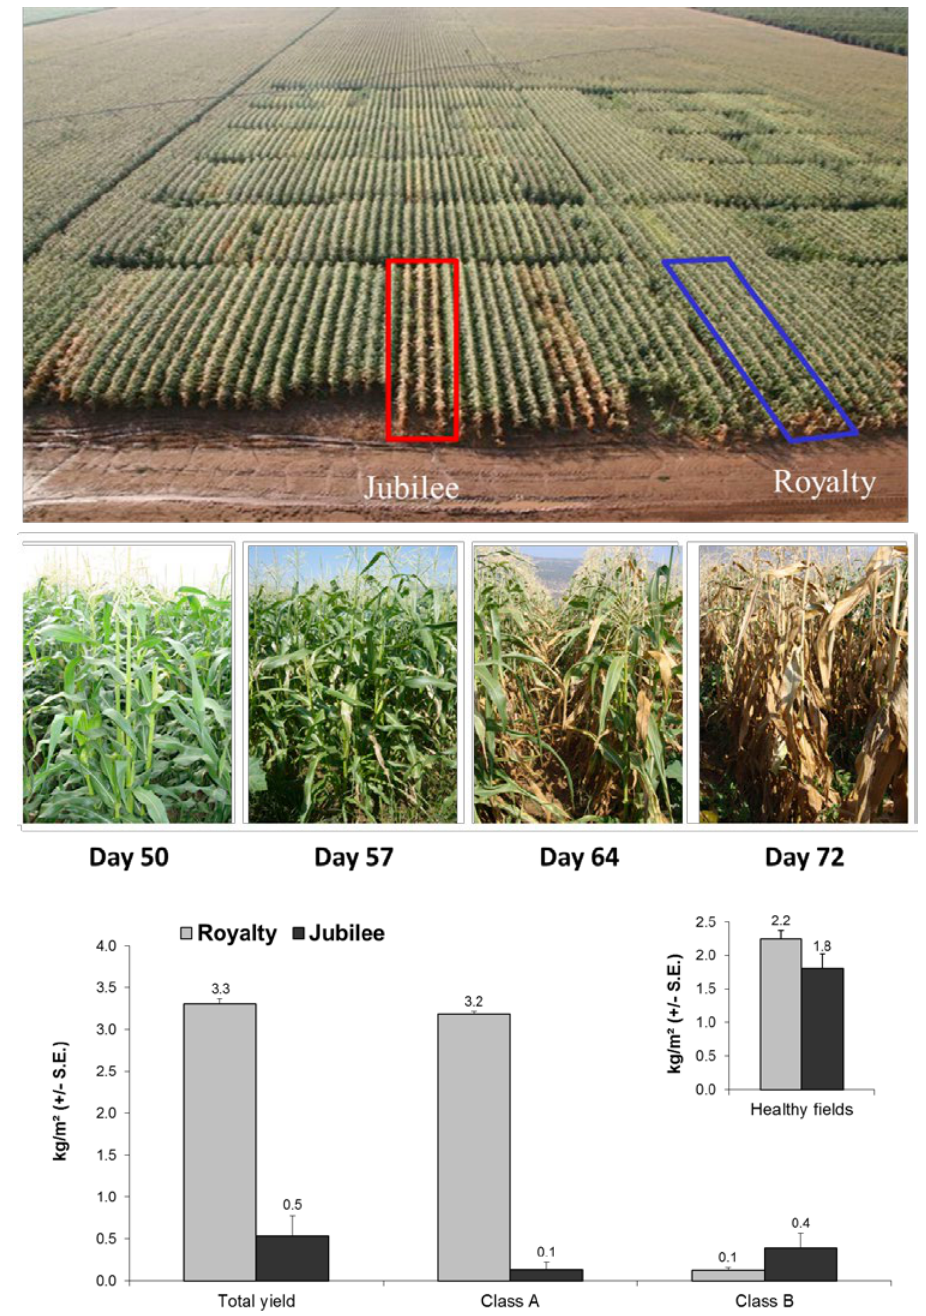
Figure 3. Field experiment for assessing cultivar resistance to Harpophora maydis in an infected sweet corn field in the Hula Valley (Upper Galilee, northern Israel). Aerial photograph (upper panel) of the maize field 75 d after sowing, wilted cv. Jubilee plants (red box) and cv. Royalty plants (blue box). Disease progression in cv. Jubilee plants from 50 to 72 d after sowing is shown in the middle panel. Maize yield (lower panel) includes all maize cobs collected from the experimental field (in kg m -2 ); Class A yield (cobs weighing more than 250 g) and Class B yield (cobs weighing less than 250 g, see Figure 5A). Insert in lower panel shows total average yield of cv. Royalty and Jubilee in the same region, the Hula Valley (2000, 2002), and Beit Shean (2005), in the last years before the spread of late wilt disease to this